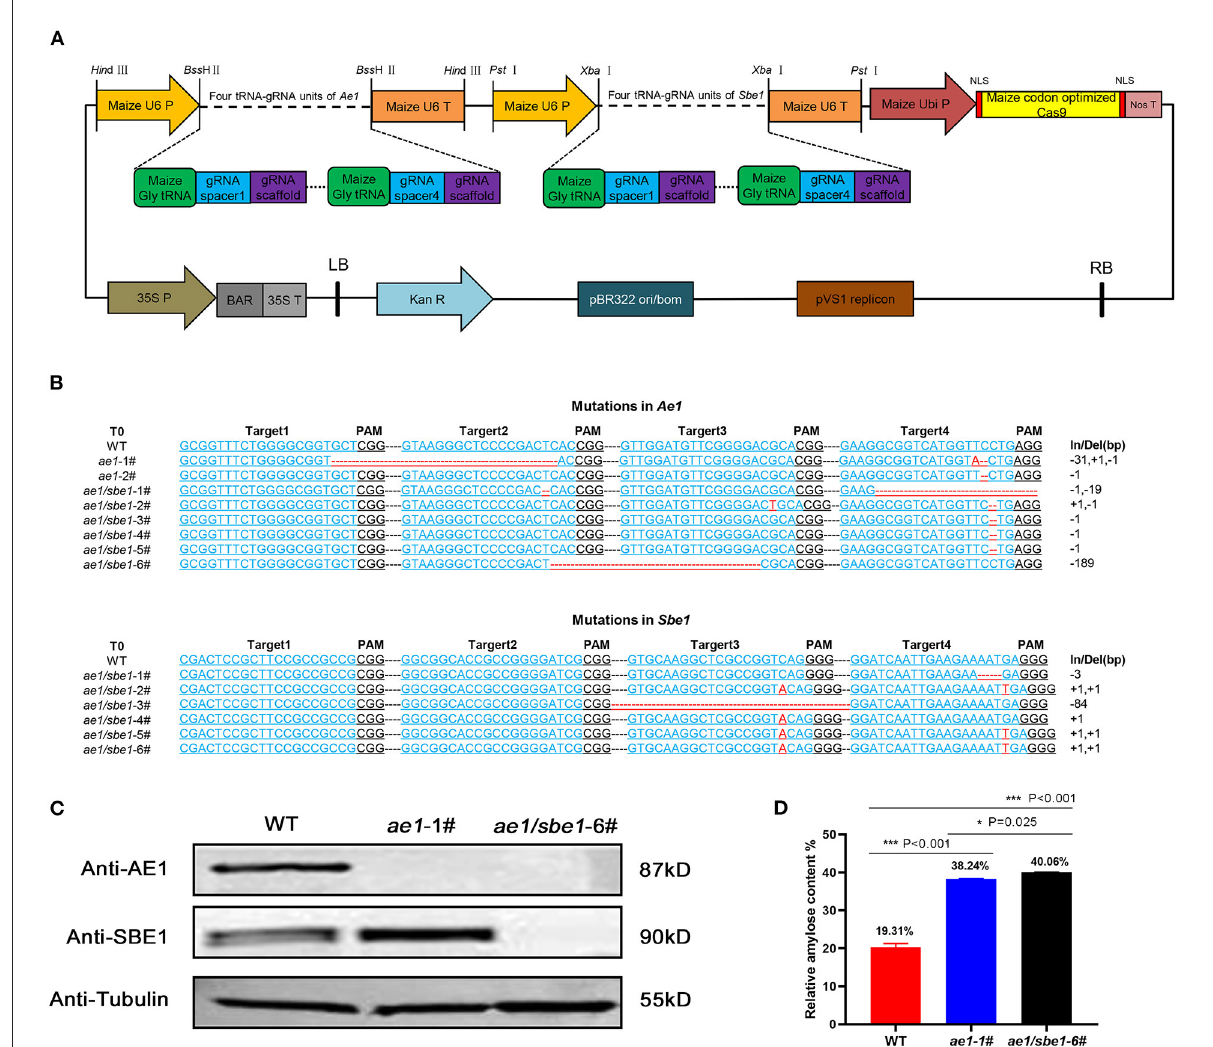
FIGURE1 Acquisition and analyses of transgenic maize. (A) The AE1/SBE1 -CRISPR/Cas9 vector based on pCAMBIA3301. P, promoter; T, terminator; Ubi P, ubiquitin promoter; NLS, nuclear localization sequence; Nos T, nopaline synthase terminator; BAR, phosphinothricin R; Kan R, kanamycin resistance gene; LB, left border; RB, right border; (B) The editing DNA sequence of transgenic lines. The 20-bp gRNA spacer sequence for the Cas9/gRNA complex is in blue, and the PAM site is in black. Deleted nucleotides and inserted nucleotides are shown in red. The lengths of the insertions or deletions (In/Del) are presented. WT, wild type. (C) Immunoblot analysis of AE1 and SBE1 in WT and mutants. Tubulin was employed as an internal control. (D) Relative amylose content of WT, ae1-1# and ae1/sbe1 -6# ( n = 5 biologically independent animals; the data are presented as the mean ± SEM, * P < 0.05, *** P < 0.001, one-way ANOVA with Bonferroni post hoc